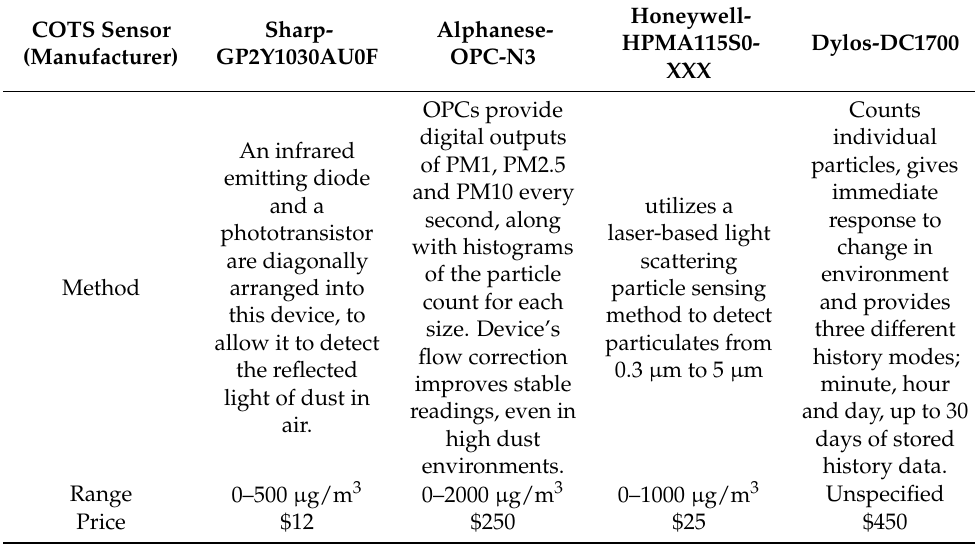
Table 1. Description of commercially off the shelf (COTS) sensors, including their operation method, range of particulate matter concentration and approximated cost (accurate as of 13 October